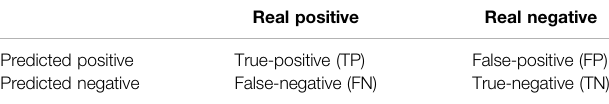
TABLE 1 | Binary classi fi cation results in a confusion matrix.